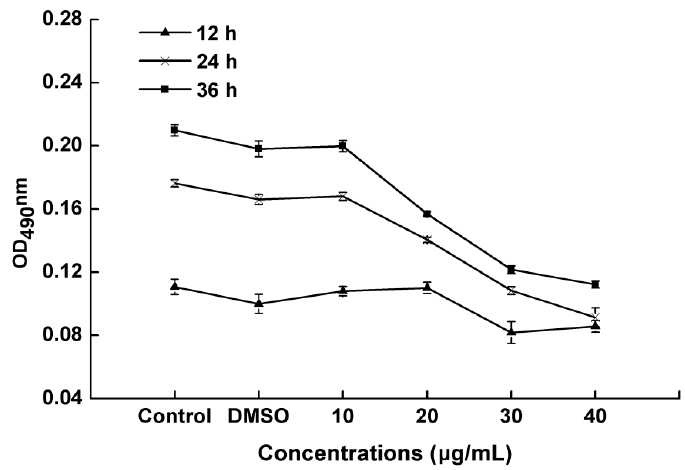
Figure 5. Effects of different concentrations (10, 20, 30 and 40 µ g/mL) of PCA on biofilm formation in R. solanacearum . Cells were treated with DMSO alone at a final concentration of 1% (DMSO treatment), sterile water (Untreated) and PCA at a final concentration of 10, 20, 30 and 40 µ g/mL (PCA treatments). Experiments were incubated for 12, 24 and 36 h at 30 °C without shaking.